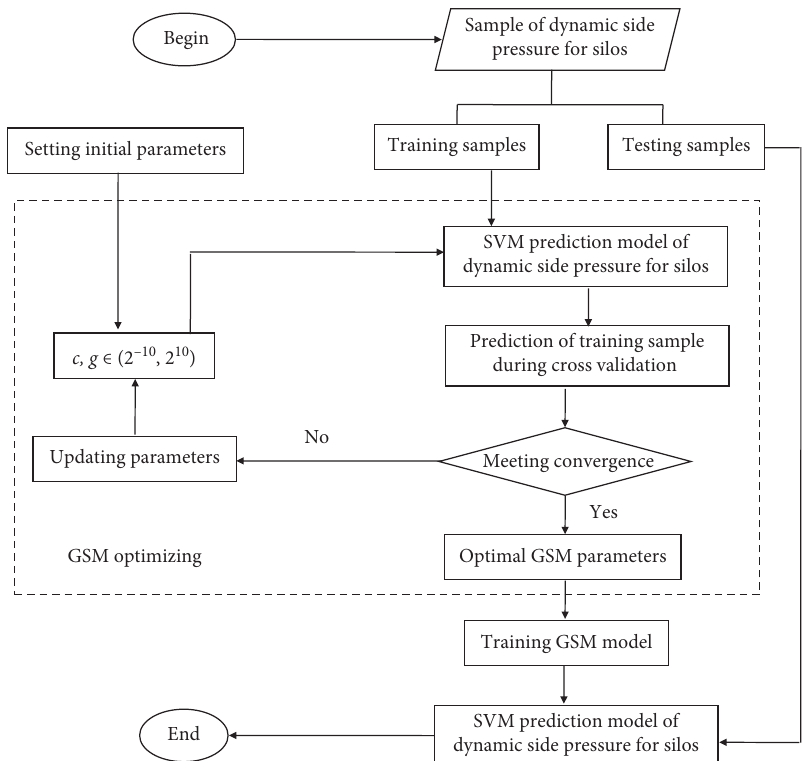
Figure 1: SVM prediction model of dynamic wall pressure for silos. Table 1: Relevant